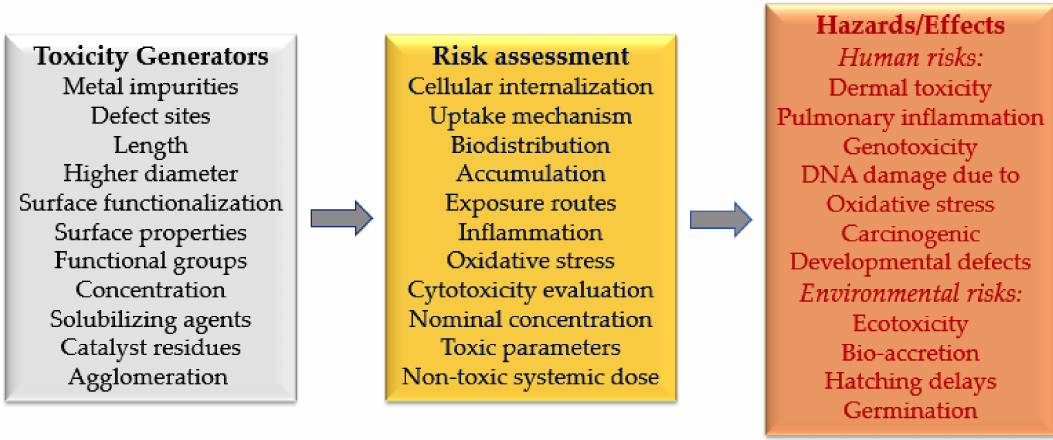
Figure 11. An insight on the factors causing toxicity, their risk assessment, and deleterious effects on humans as well as the environment by the carbon-based nanomaterials